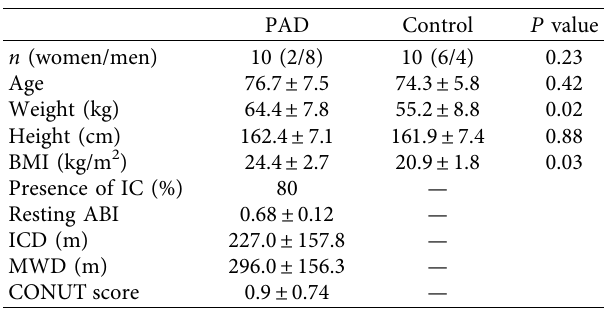
Table 1: Subjects’ characteristics.